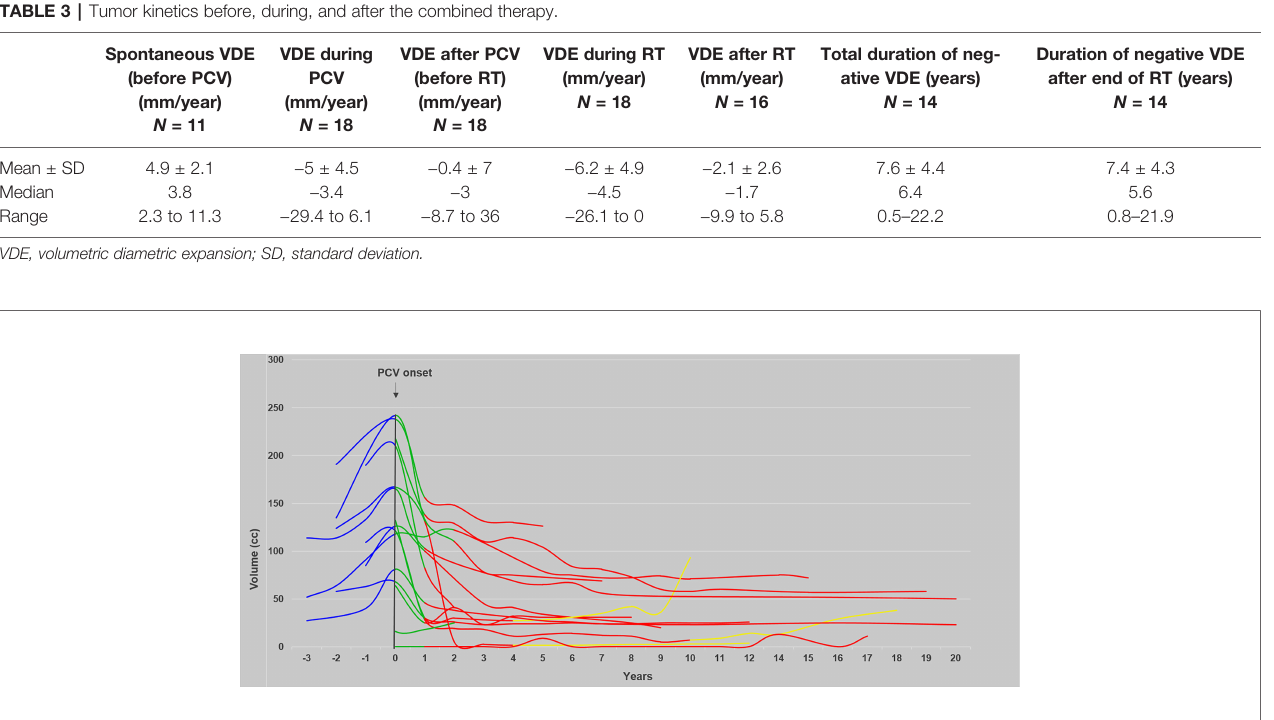
FIGURE 3 | Evolution of the tumor volume over time before, during, and after the sequence PCV followed by RT. The evolution of tumor volume before ( n = 10), during ( n = 16), and after ( n = 16) the sequence PCV followed by RT and at progression is shown in blue, green, red, and yellow, respectively.